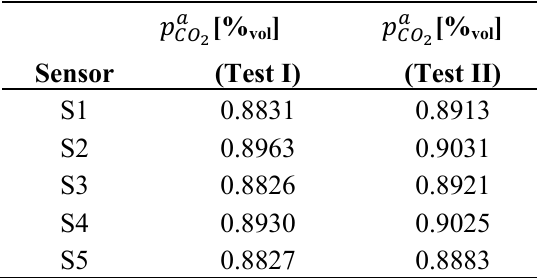
Table 6. Mean background concentrations from inverse